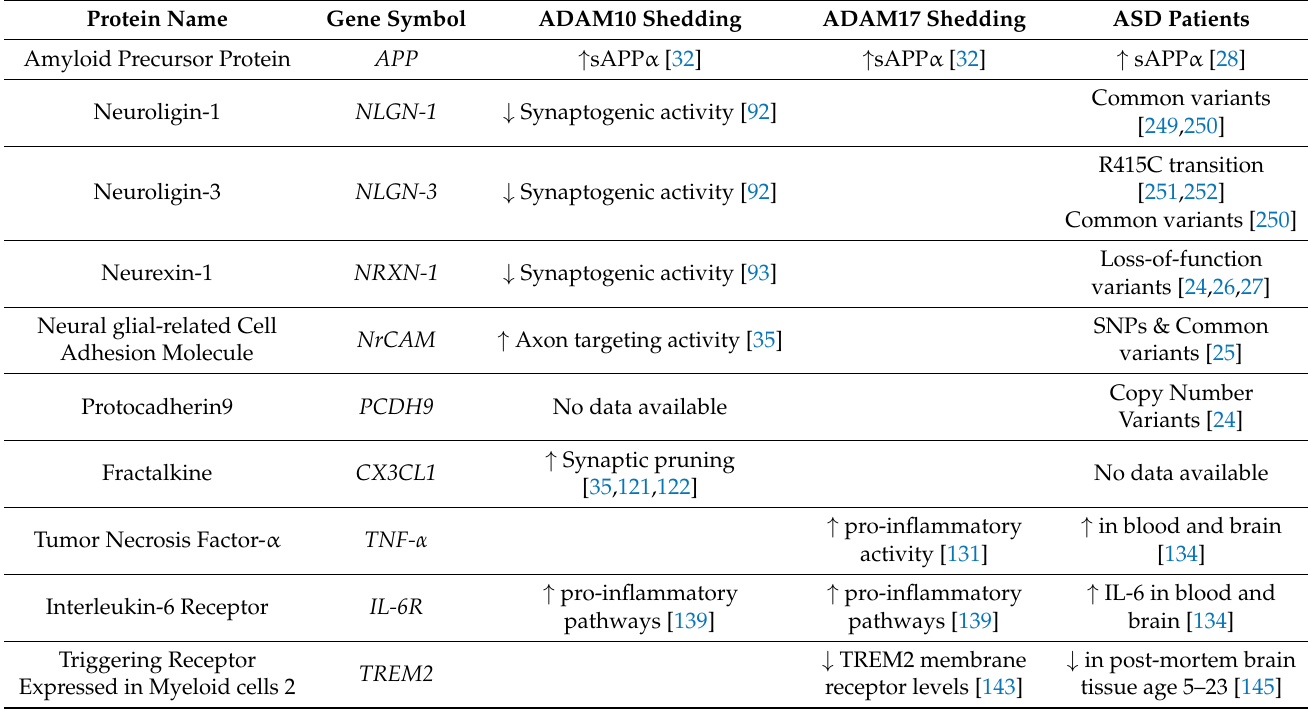
Table 2. The effect of ADAM10 and ADAM17 on different substrates and their involvement in Autism Spectrum Disorder (ASD) patients. ↓ : downregulated; ↑ :